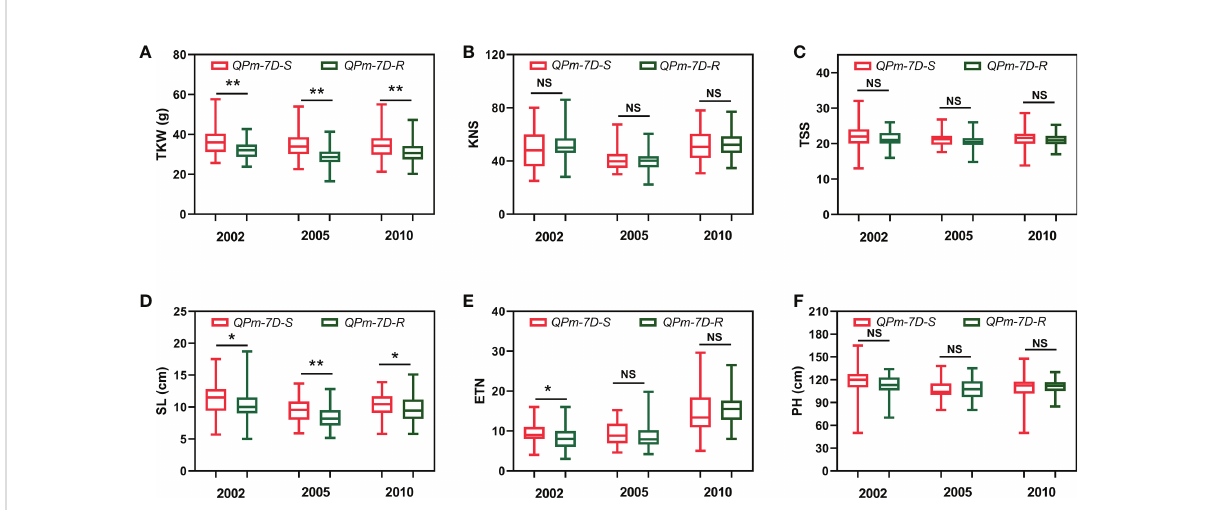
FIGURE 4 Haplotypes analysis with agronomic traits of QPm.cas-7D in the landraces of the Chinese wheat mini-core collection. Comparison analysis of QPm.cas-7D haplotypes with the TKW (A) , KNS (B) , TSS (C) , SL (D) , ETN (E) , and PH (F) of the landraces of the Chinese wheat mini-core collection in three environments. ** P < 0.01 and * P < 0.05 (two-tailed t test) indicates a signi fi cant difference to the two haplotypes. NS, no signi fi cant difference.